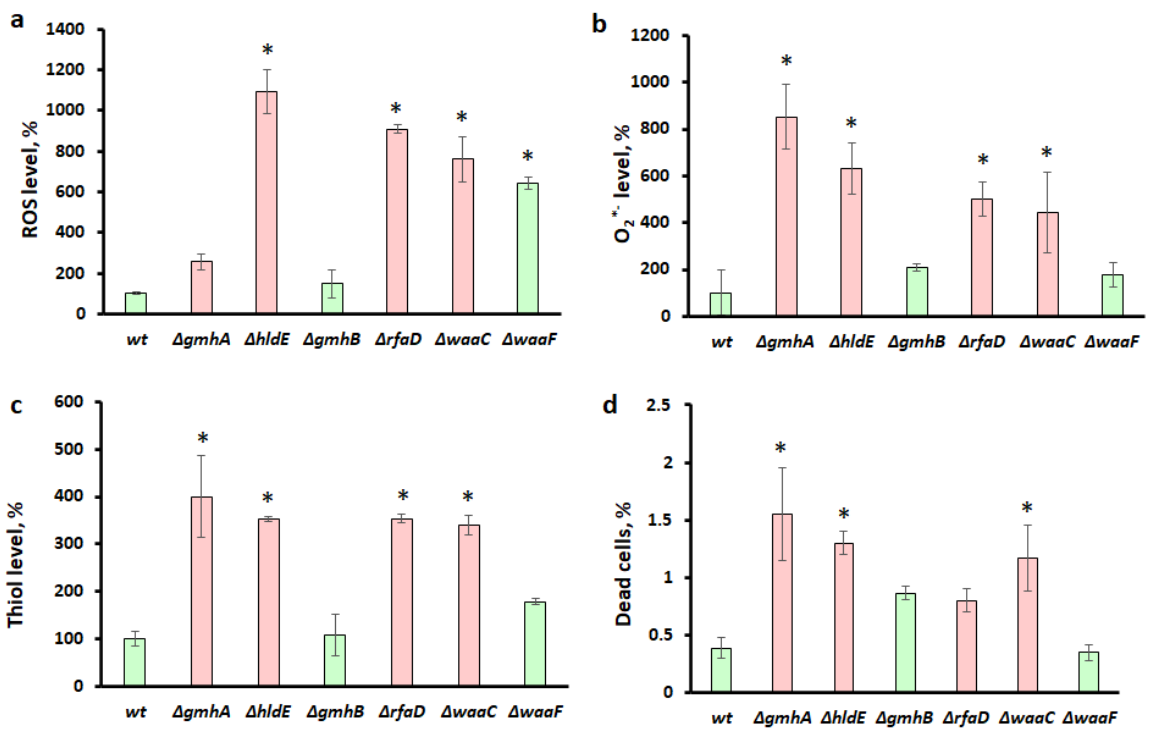
Figure 5. Changes in the level of intracellular ROS, O 2* − the level of thiols, and the percentage of dead cells in the population of E. coli cells with deletions of the gmhA, hldE, gmhB, rfaD, waaC, waaF genes. The level of ROS ( a ) was assessed using the dye DHR123; the O 2* − level ( b ) with DHE dye; the thiols level ( c ) with ThiolTracker Violet; the percentage of dead cells ( d ) was estimated using propidium iodide. Parameters for cells with gmhA , hldE , rfaD , and waaC deletions that result in a dramatic increase in antibiotic susceptibility in E. coli cells are shown in red, while parameters for wt , gmhB, and waaF are shown in green. Mean values ± SD from at least three independent experiments are shown. * — p < 0.05, compared to the wild-type cells.